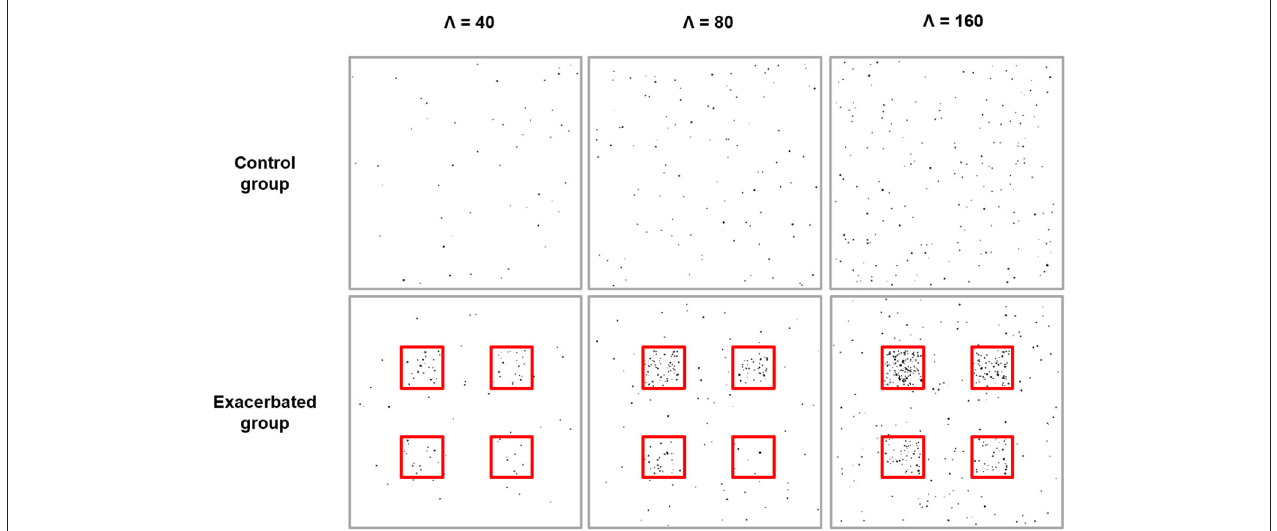
FIGURE 1 | Simulation experiments. From left to right: simulation experiments with basal expected number of disks, 3 , equal to 40, 80, and 160, respectively. For each experiment, one example of a simulation image from the control group is shown at the top and one example of a simulation image from the exacerbated group is shown at the bottom. Disks appear in black and the underlying cluster boundaries are shown in red. For each experiment, the expected relative increase in the number of disks per cluster is either 20 (top left cluster), 10 (top right cluster), 5 (bottom left cluster), or 2.5 (bottom right